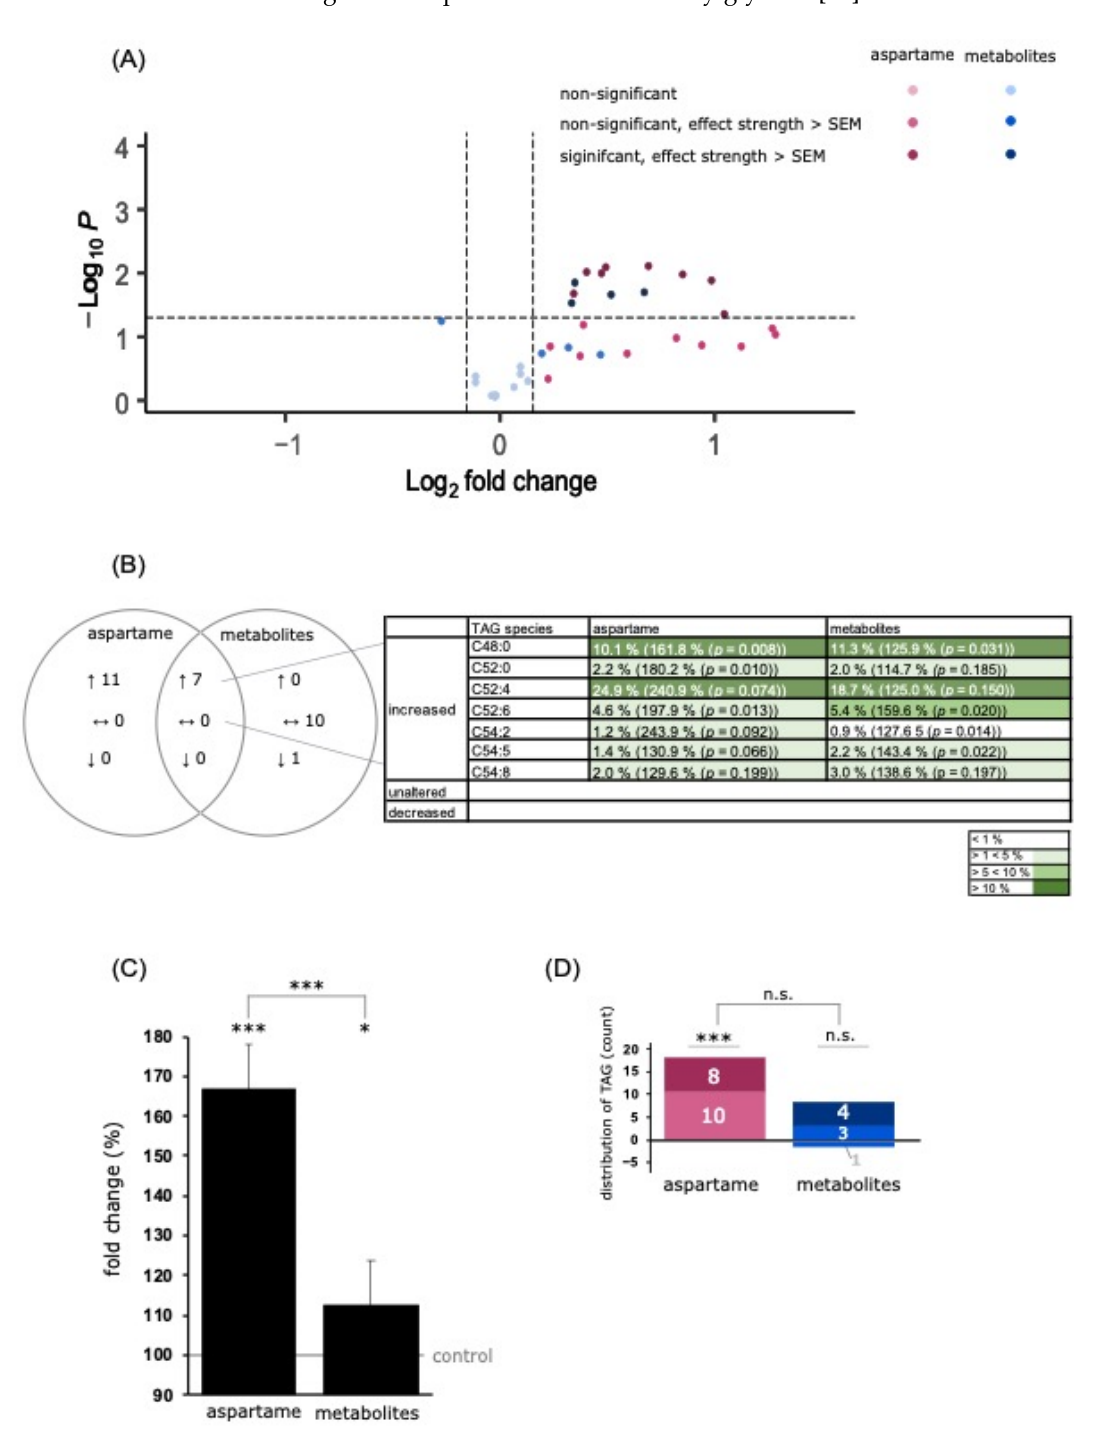
Figure 4. E ff ects of aspartame or aspartame metabolites on triacylglycerol (TAG) species. Neuroblastoma cells (SH-SY5Y) were treated as described before with control, aspartame, or aspartame metabolites for 48 h and analyzed using a semi-quantitative shotgun lipidomics approach. Each diagram represents the changes in the aspartame- or metabolite-treated cells in comparison to control-treated cells. ( A ) In the volcano plot, each triglyceride species is graphically represented by a pink (aspartame treatment) or blue (aspartame metabolite treatment) dot which is plo tt ed with its fold change ( x -axis) against its according p -value ( y -axis). Light blue and light pink dots represent no signi fi cant changes. Medium blue and medium pink dots represent a fold change which is greater than the mean standard error of the mean (SEM). Dark blue and dark pink dots represent a fold change which is greater than the mean SEM and in addition has a p -value smaller than 0.05 (which was de fi ned as the statistical signi fi cance level). ( B ) Venn diagram of TAG species after incubation